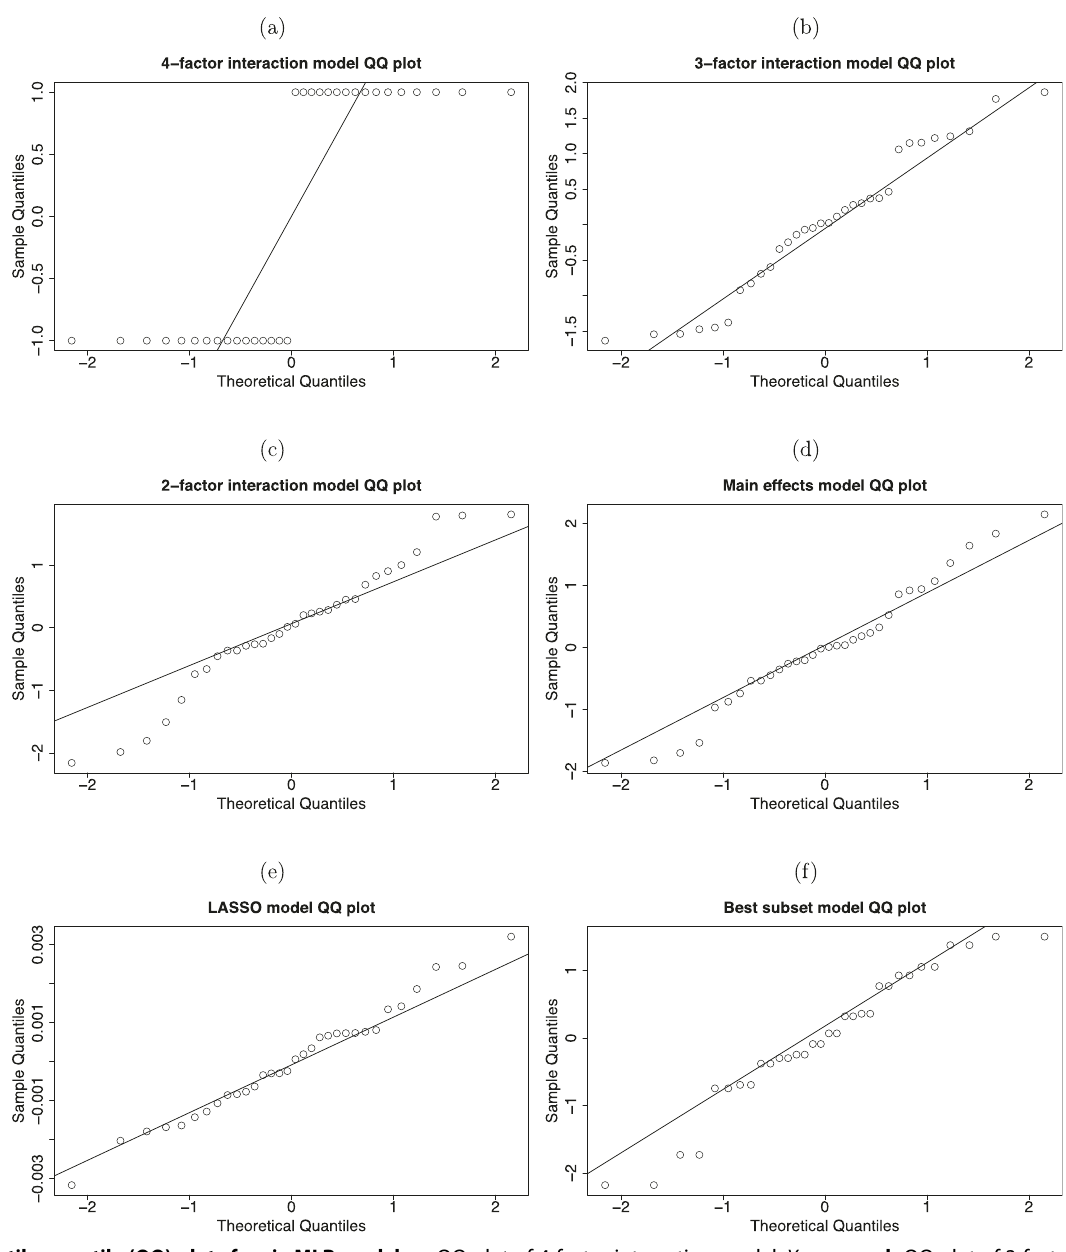
. b QQ plot of 3-factor interaction i 1 X i 2 X i 3 X i 4